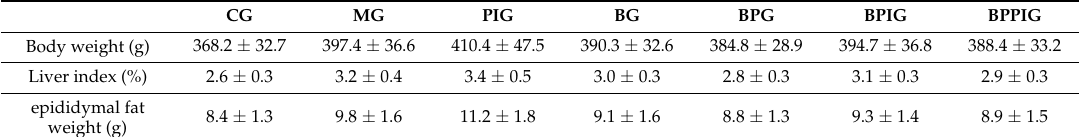
Table 4. The comparison of liver and fat body weights among different